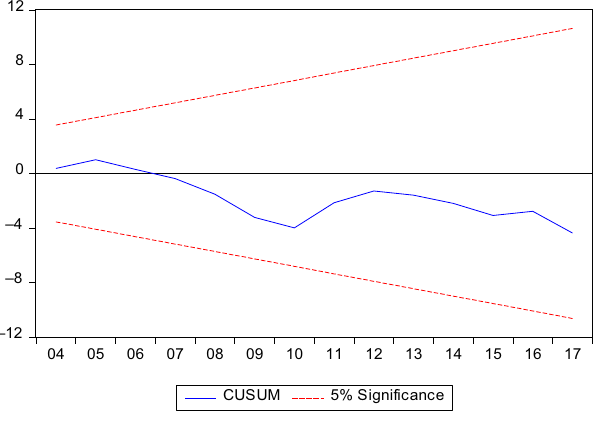
Figure 5. Plot of CUSUM test (Model 1)